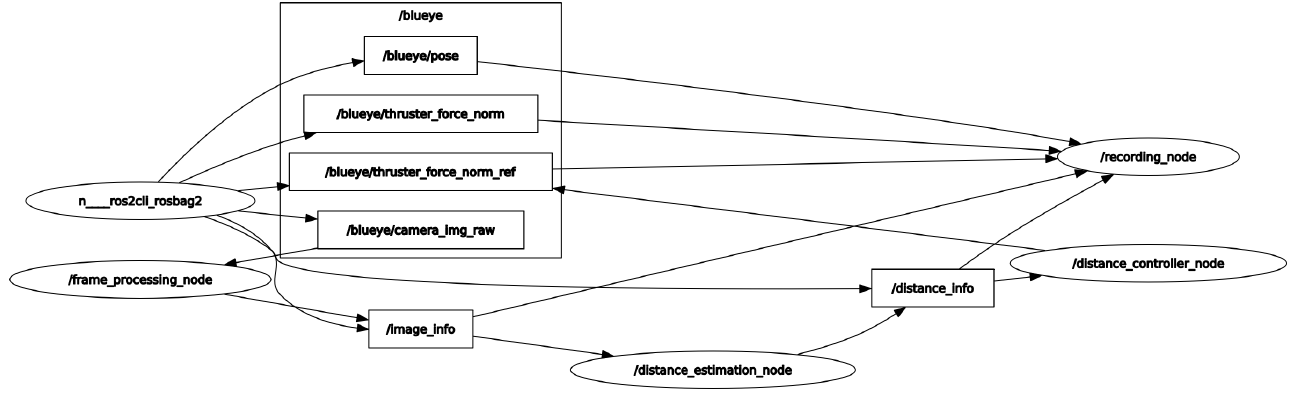
Figure 18. Screenshot of rqt-graph of all the ROS nodes during